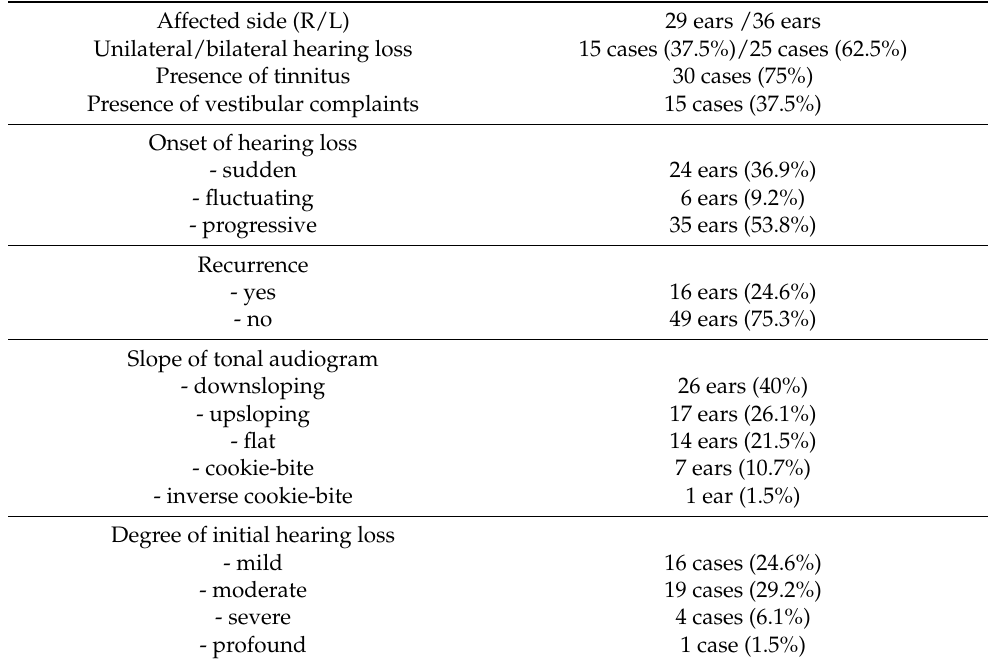
Table 3. Audiological symptoms and initial audiometric characteristics in patients (40 cases, 65 ears) with autoimmune hearing loss and carriers of HLA B27, B35, B51, C4, C7, and DRB1*04